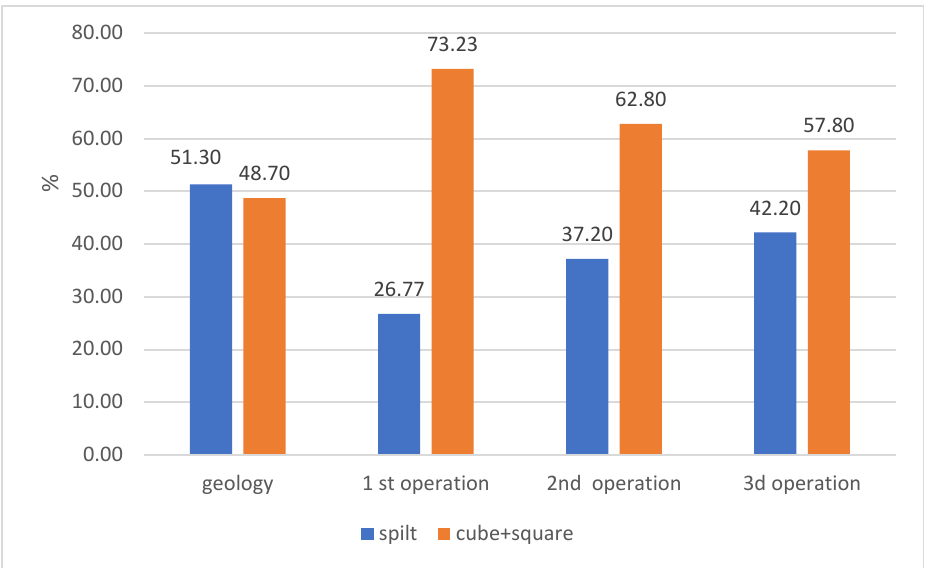
Figure 8. The experimental results: comparison of the distribution of a cubic together with square and spilt fragment form based on the mean values for the three experiments.